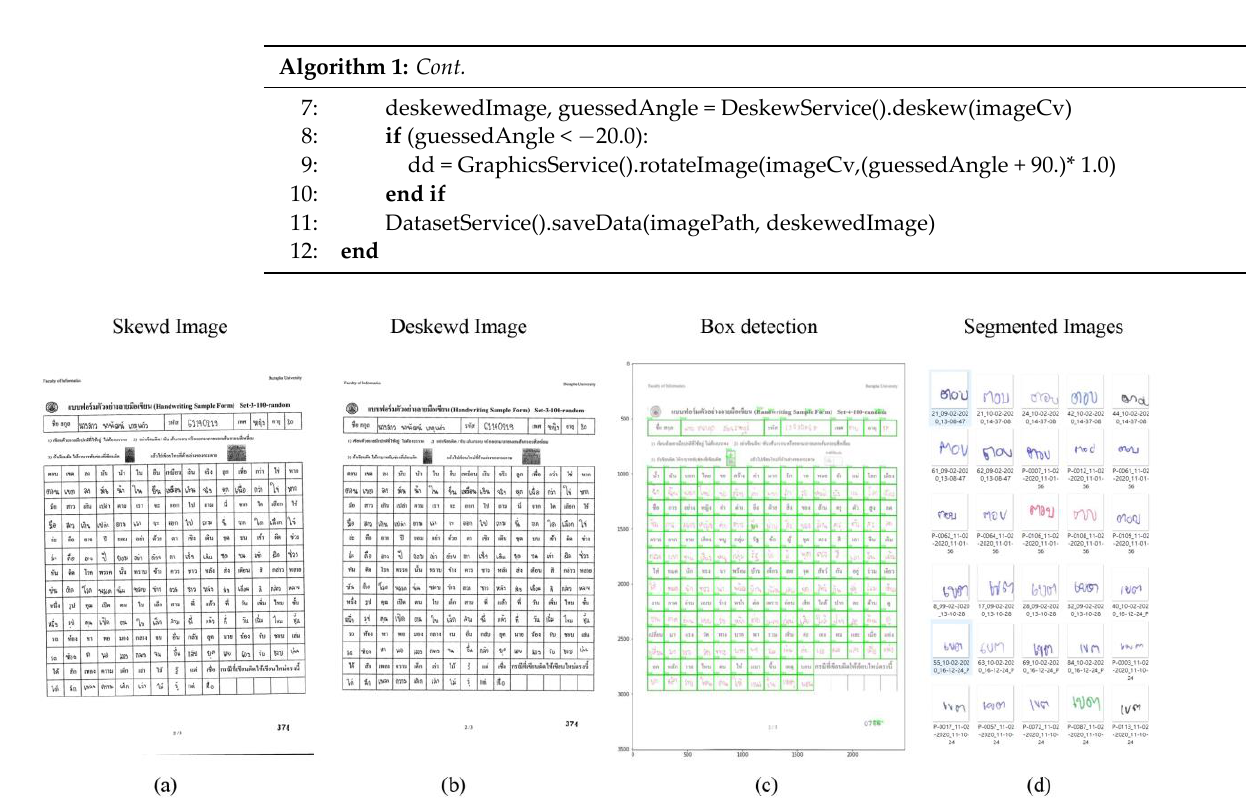
Figure 5. Overall procedure of data preparation process: ( a ) is an original image from a document scanner, ( b ) depicts output images from Algorithm 1, ( c ) shows line detection process from Algo- rithm 2, and ( d ) depicts output from Algorithm 3. Algorithm 1: Pseudo-code of Image_deskewing